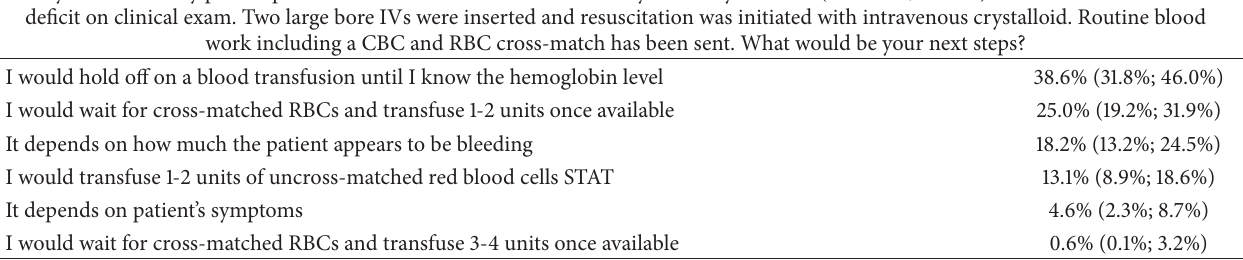
Table 3: Clinicians deciding on the best next step in management of an actively bleeding patient with UGIB (see scenario below). A 50-year-old healthy patient presents with hematemesis and is hemodynamically unstable (BP 90/50, HR 115) with evidence of a volume deficit on clinical exam. Two large bore IVs were inserted and resuscitation was initiated with intravenous crystalloid. Routine blood